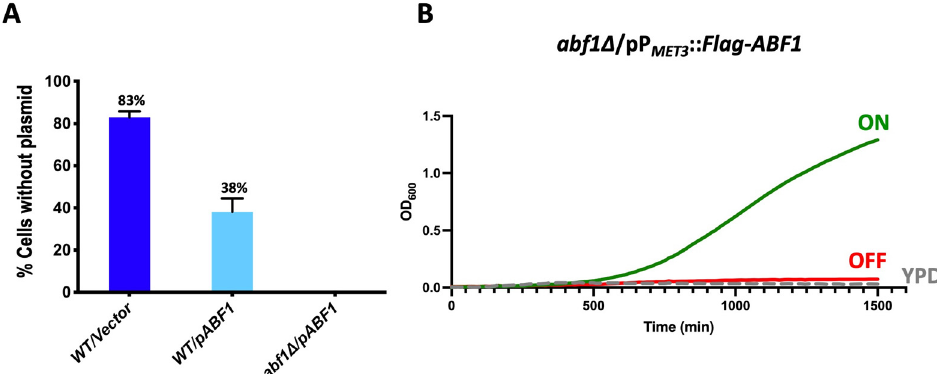
Figure 2. Cg Abf1 is an essential protein for growth in C. glabrata . ( A ) The indicated strains were grown in YPD rich media (without selection) for 72 hours, diluting in fresh media every 12 h after which cells were diluted and plated on YPD and incubated 48 h at 30 °C. Plates were replica-printed onto SC + 5-FOA, SC—uracil and YPD plates to determine the number of Ura − colonies. The graph shows the percentage of cells that lost the plasmid in each culture, and the numbers represent the mean of three separate experiments ± SD. ( B ) Cells from strain abf1 ∆ /pP MET3 ::Flag- ABF1 (shut off plasmid) were grown in YNB minimal media (ON) for 48 h. Cells were adjusted to an OD 600 of 0.01 and inoculated into three media: ON (in green) (YNB minimal media); OFF (in red) (YNB + 0.2 mM each cys and met), and YPD rich media (in broken gray lines). The OD 600 was recorded every 15 min in Bioscreen C equipment. The graph represents the mean of three biological replicates with three technical replicates each (see Sections 2.4 and 2.6).